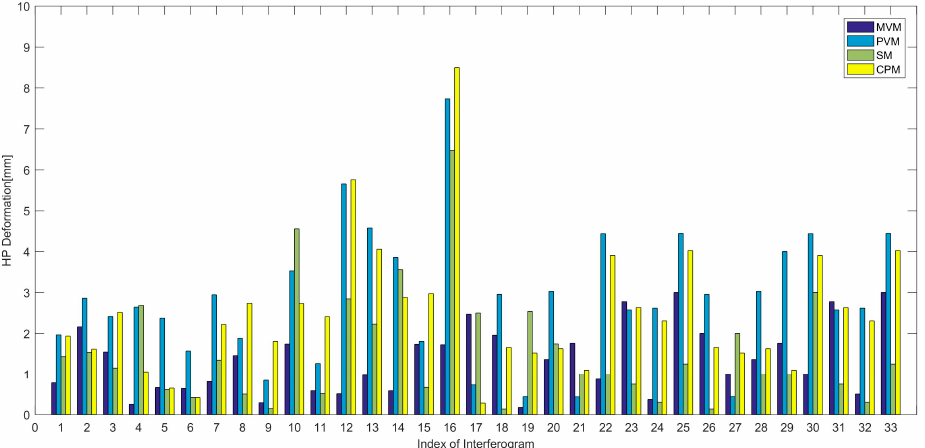
Figure 13. RMS of HP deformation of 25 inteferograms comparison for four models ( a ) MVM; ( b ) PVM; ( c ) SM; ( d ) CPM.